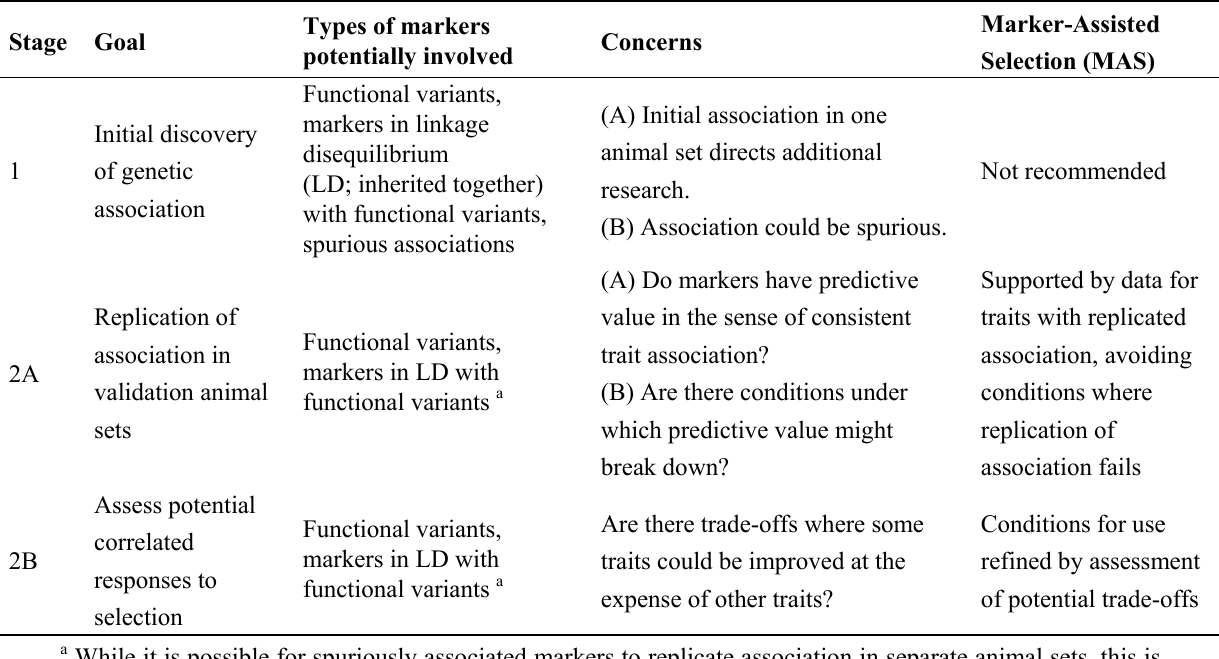
Table 1. Evidence-Based Stages for Genetic Marker